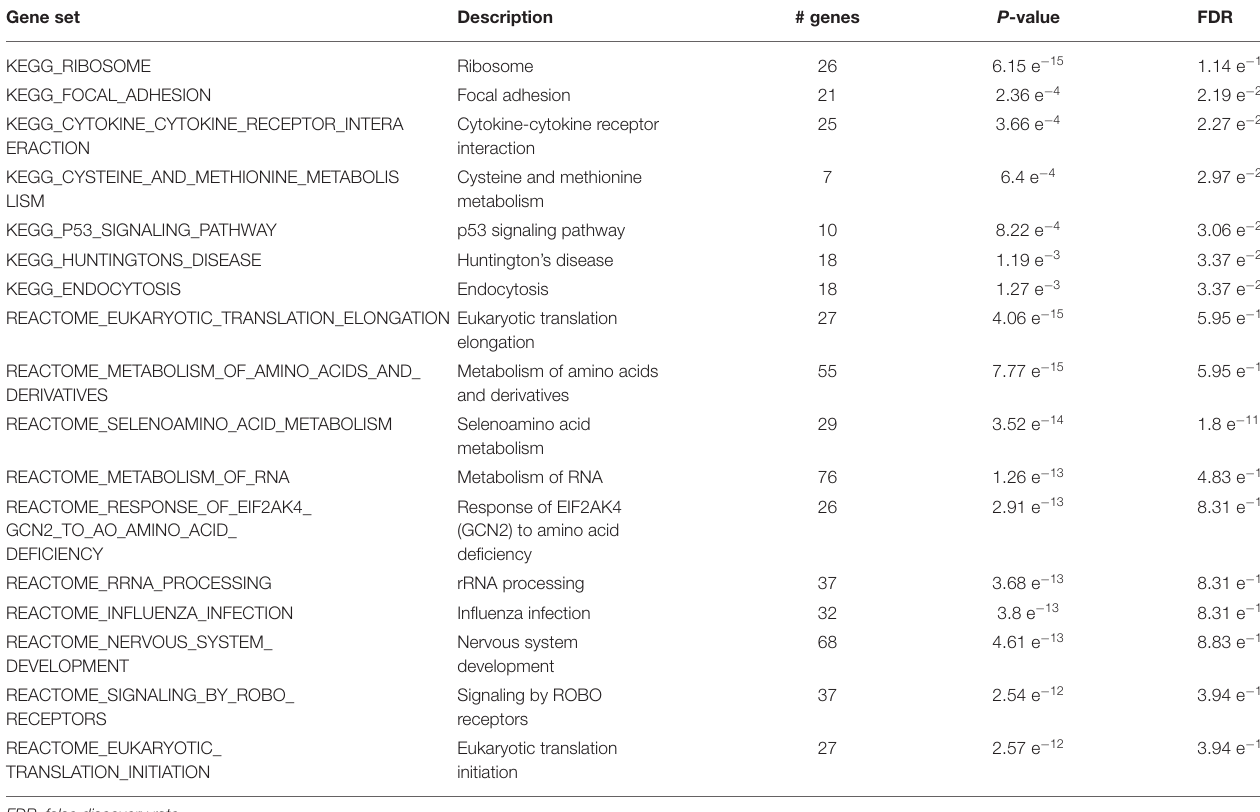
TABLE 2 | Top 20 significant KEGG and Reactome biological pathways from GSEA. Gene set